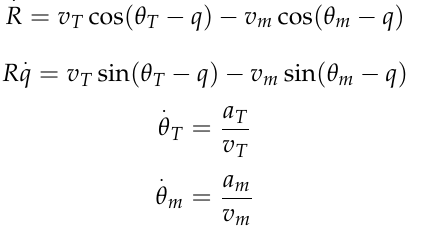
Figure 2. Dynamics of the missile in the pitch plane. Figure 1 denotes the pursuit geometry of the missile–target in the pitch plane. XOY is the inertial coordinate system.